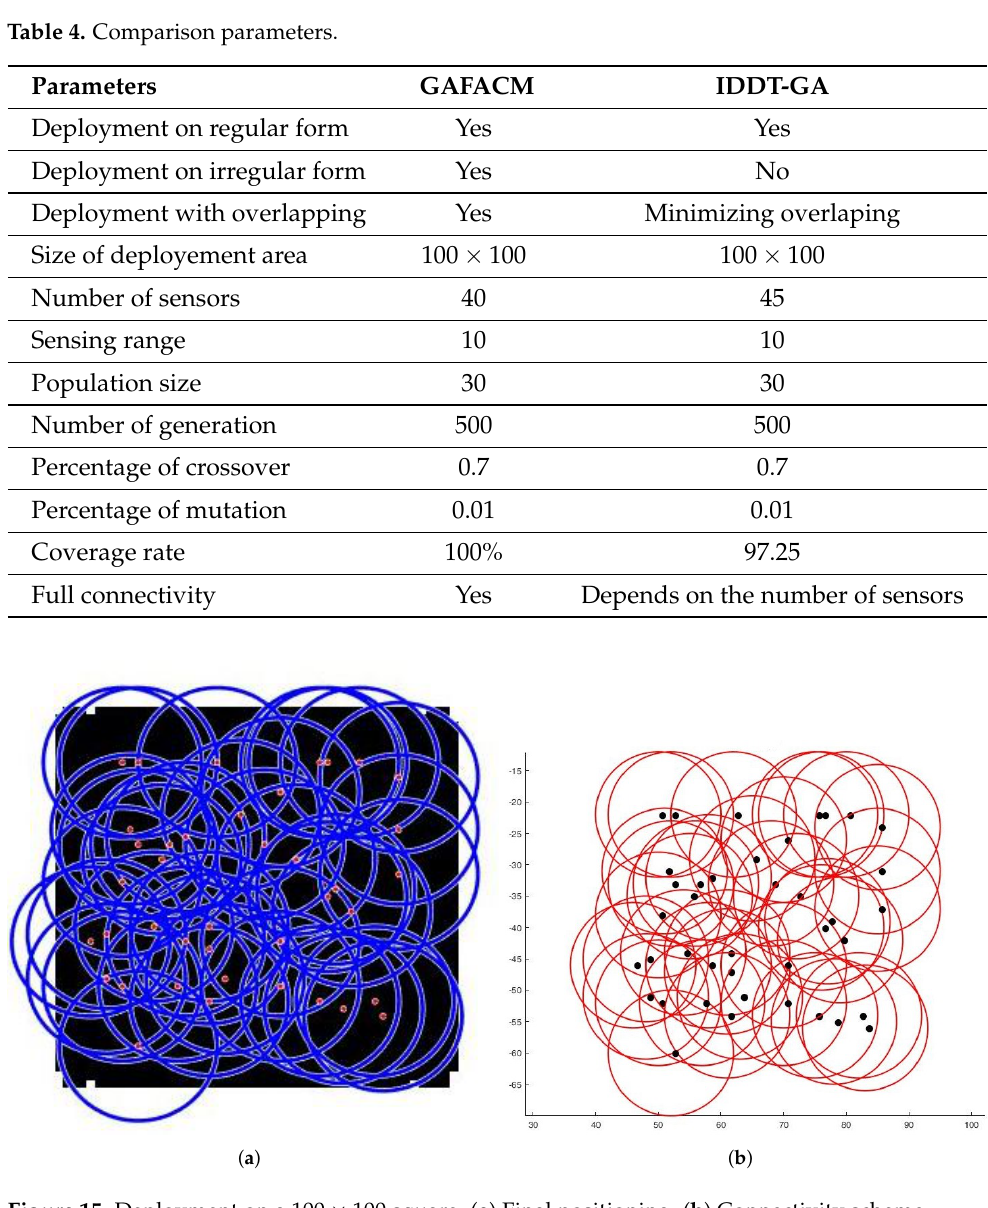
Figure 15. Deployment on a 100 × 100 square. ( a ) Final positioning. ( b ) Connectivity